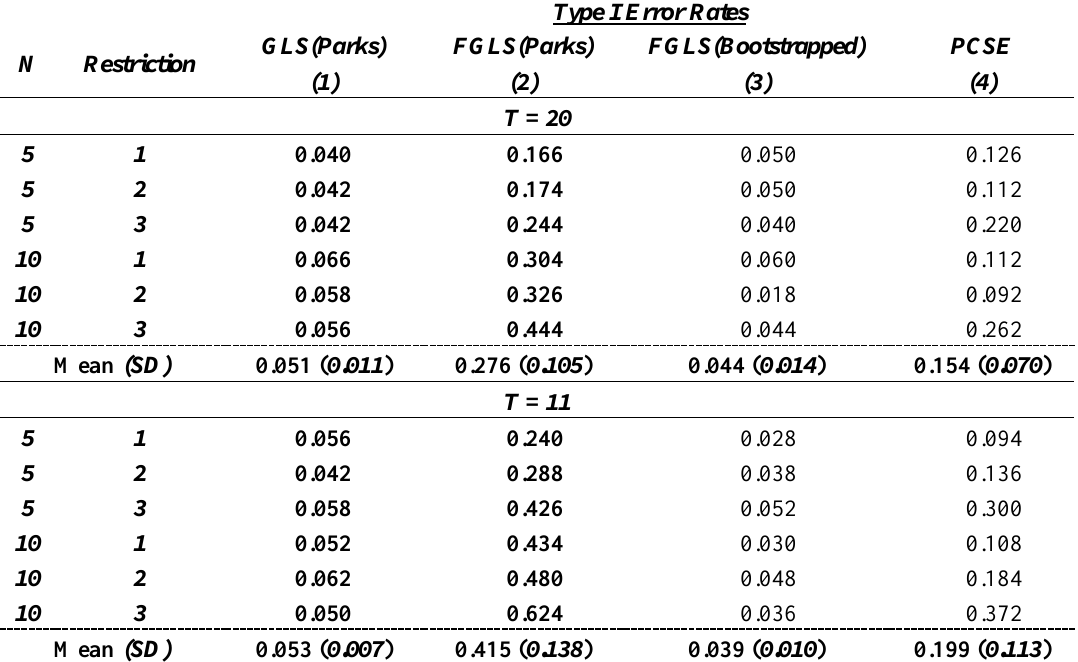
Table 2 : Comparison of type I error rates using